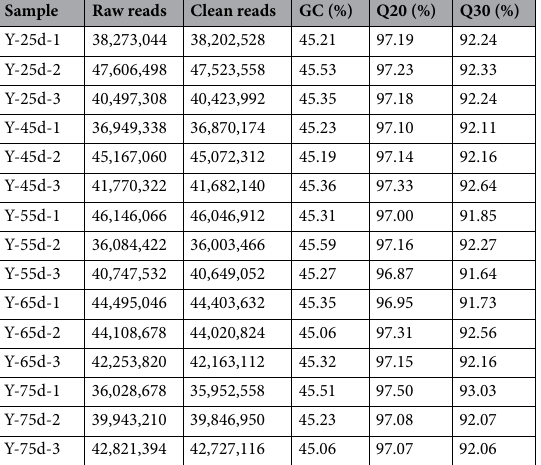
Table 1. Summary of sequencing data. Y-25d callus at 25 days, Y-45d callus at 45 days, Y-55d callus at 55 days, Y-65d at 65 days, Y-75d callus at 75 days, Raw reads original number of reads obtained by sequencing, Clean reads number of reads after removing low-quality reads and trimming adapter sequences, GC% percentage of G and C in total bases, Q20 Phred score, indicates 99% accuracy of sequenced bases, Q30 Phred score, indicates 99.9% accuracy of sequenced bases.